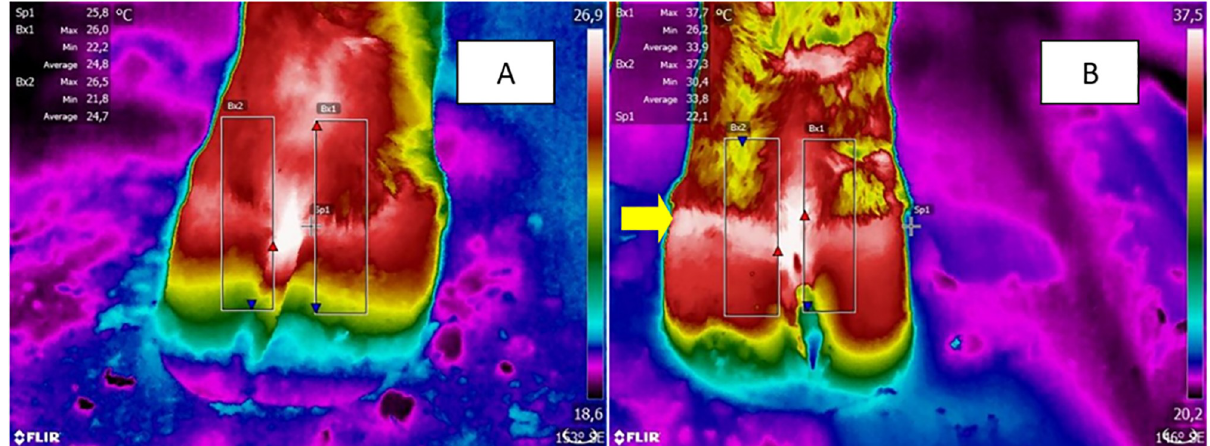
Fig 1. Infrared thermography of the left thoracic limb at baseline (A) and after experimentally induced laminitis (B). The white area indicated by the yellow arrow in the region of the coronary band indicates area of higher temperature.